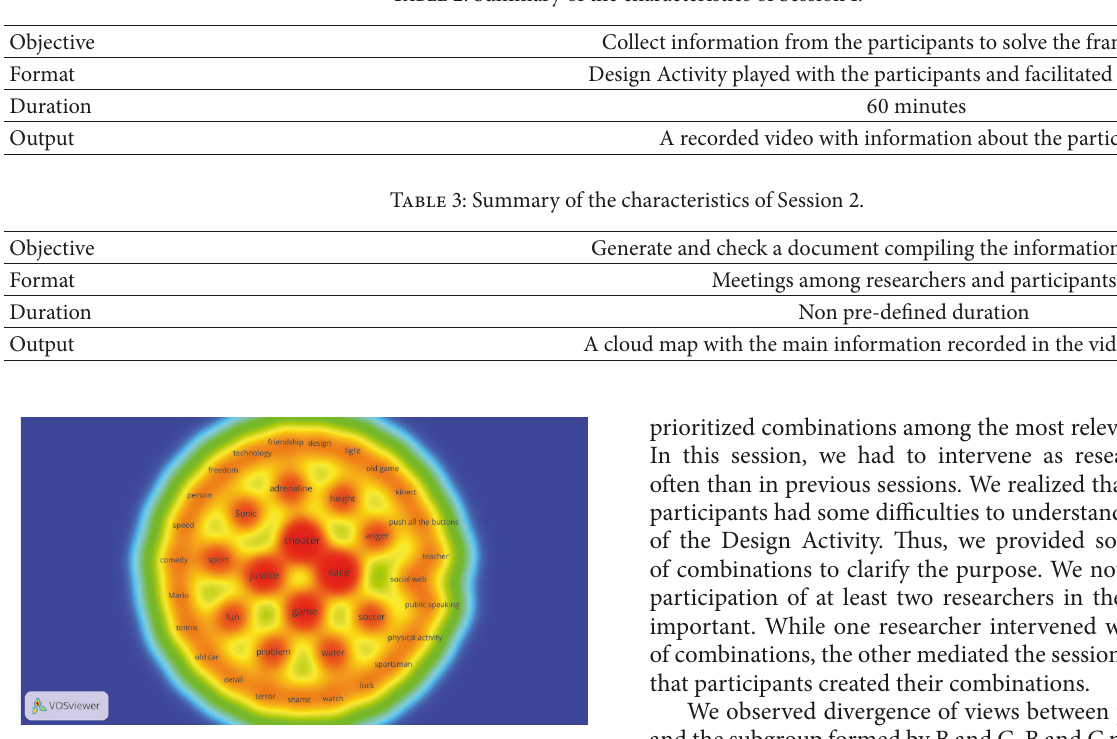
Table 2: Summary of the characteristics of Session 1.